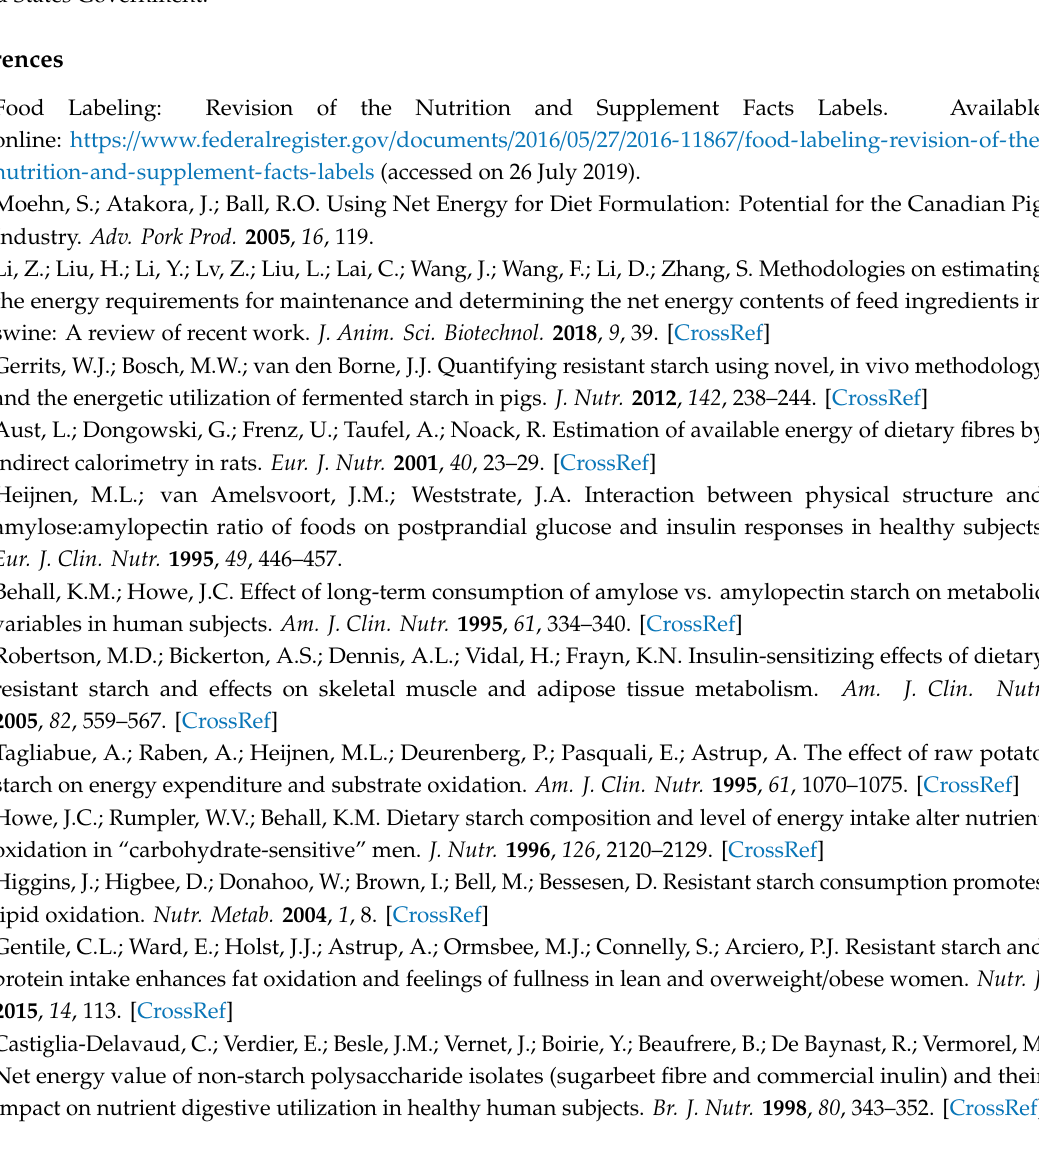
Figure S1: Non-protein Respiratory Quotient (npRQ). 24 h npRQ, following consumption of digestible starch (DS), resistant starch (RS), or resistant starch with high fiber (RSF), as measured by whole-room indirect calorimetry. Data are expressed mean ±